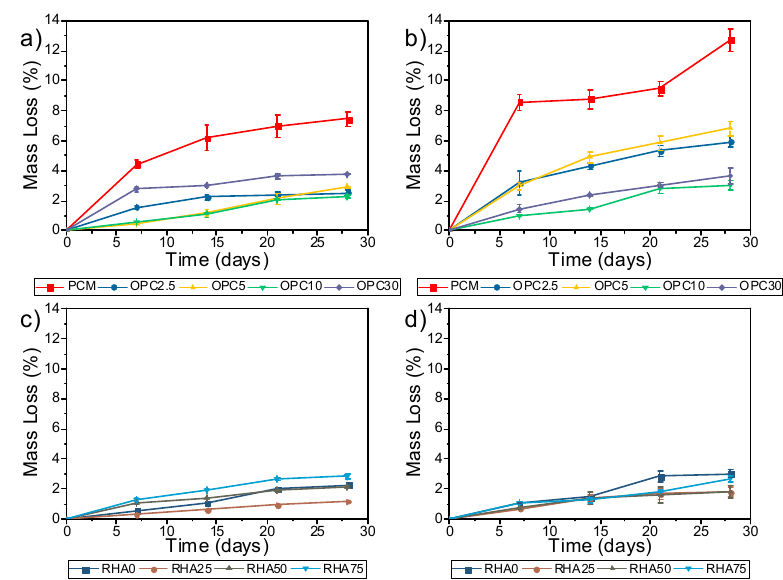
Figure 5. Mass loss of binary and mortars during acid attack: ( a ) Binary after HAc exposure; ( b ) Binary after HCl exposure; ( c ) Ternary after HAc exposure; ( d ) Ternary after HCl exposure.